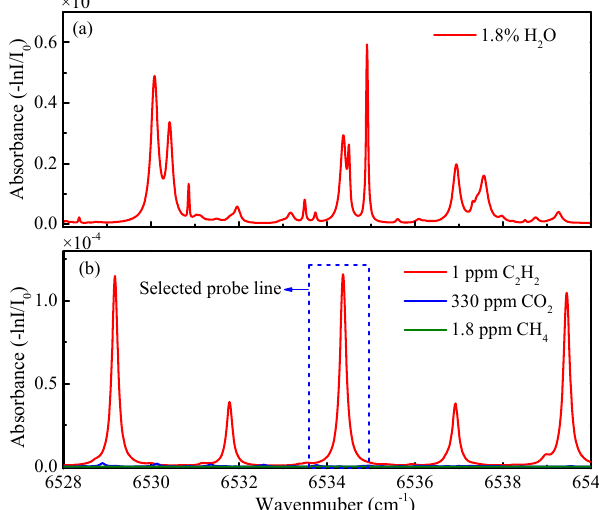
Figure 2. The absorbance of mixed gases from 6528 cm − 1 to 6540 cm − 1 at a simulation condition of 1 atm, 298 K, and a path length of 100 cm. ( a ) 1.8% H 2 O ( b ) 1 ppm C 2 H 2 , 330 ppm CO 2 , and 1.8 ppm CH 4 .